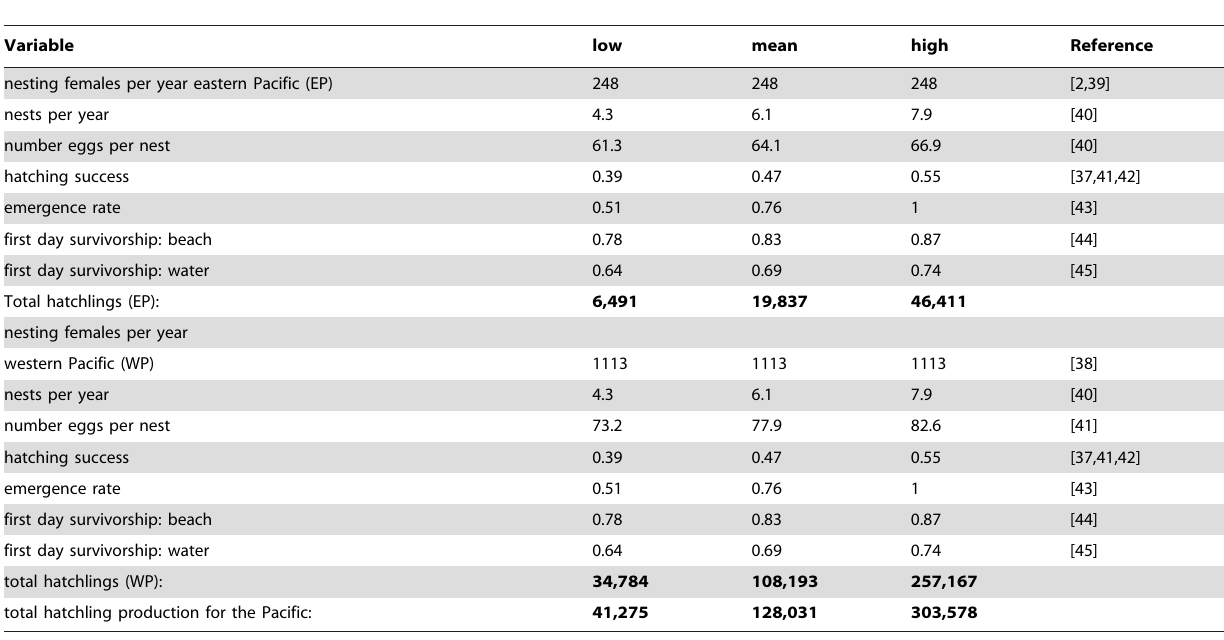
Table 1. Total number of hatchlings entering the Pacific Ocean each year calculated from nesting ecology data from the literature.